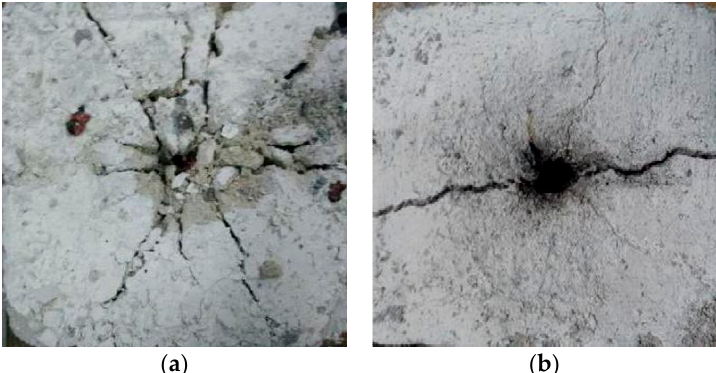
Figure 9. Blasting fracture propagation: ( a ) blasting without a PVC pipe; ( b ) directional blasting with PVC pipe punching.